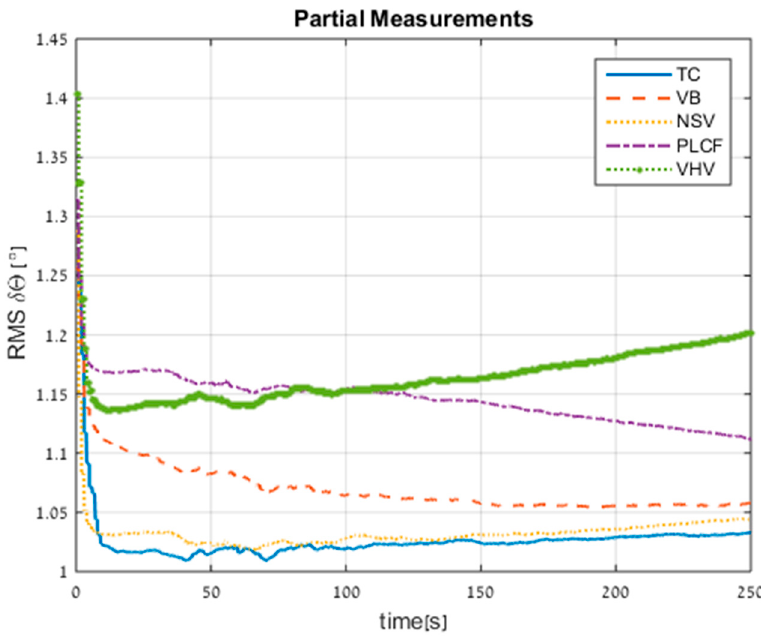
Figure 10. RMS errors of attitude for all approaches obtained from trajectory #1.